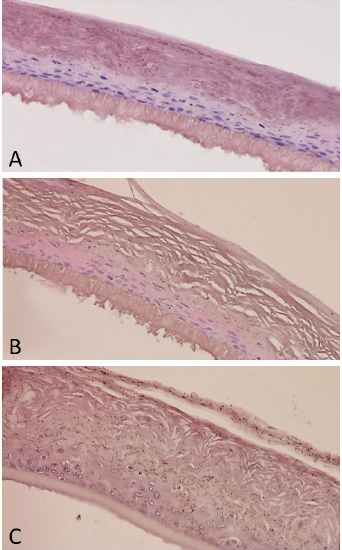
Figure 7. Histology of EpiSkin after exposure to ZLF-A (0.10% w / w )-enriched cream ( A ), ZLF-A extract ( B ), Triton × 100 ( C ); negative control). Hematoxilin-Eosin staining. ×